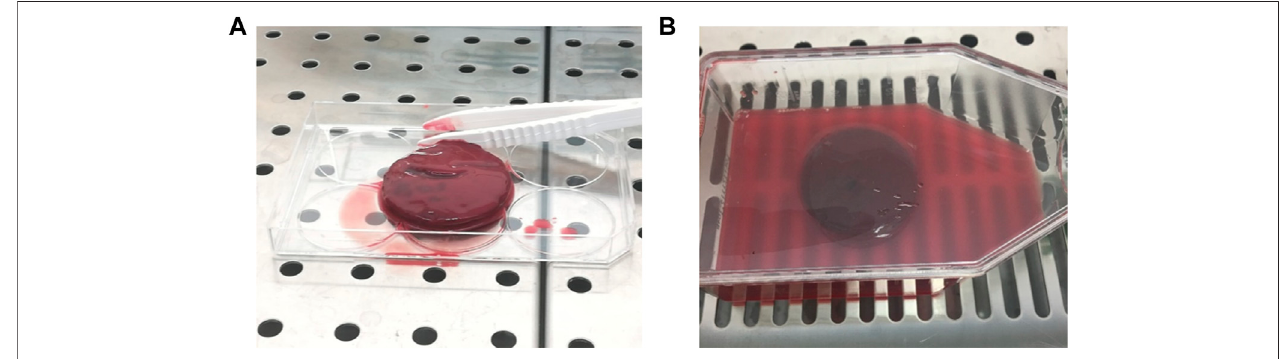
FIGURE 1 | Clotted BMA (A) after the remotion from the disposable plastic graduated container and (B) in the culture fl